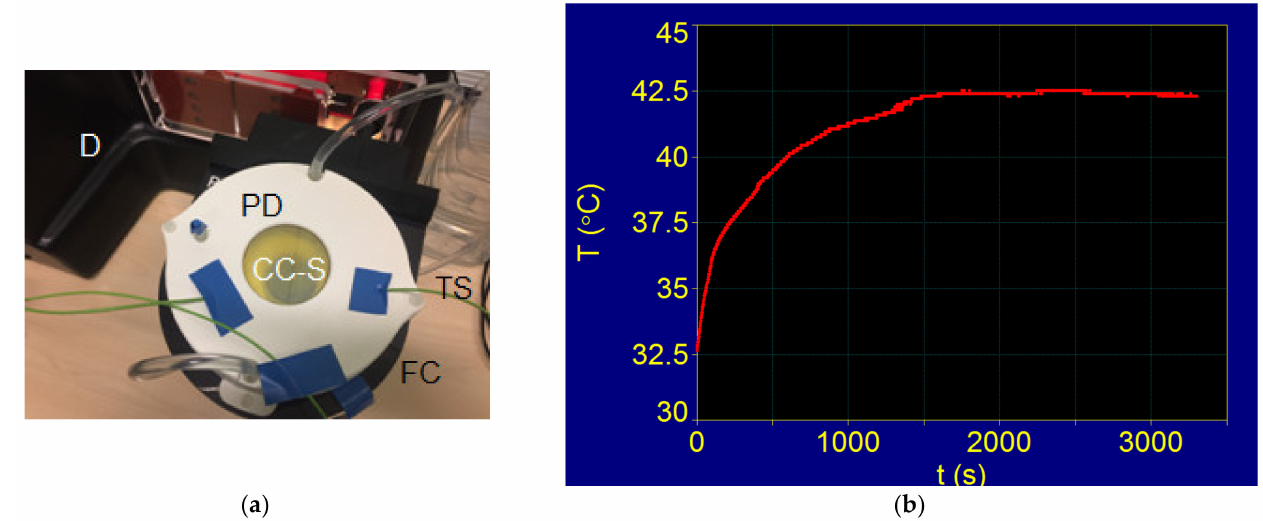
Figure 15. ( a ) Coil magnetic hyperthermia generator for in vitro studies; CC-S: cell culture with Fe 3 O 4 - PAA–(HP- γ -CDs) nanobioconjugates; ( b ) T–t diagram for cell culture with Fe 3 O 4 -PAA–(HP- γ -CDs)